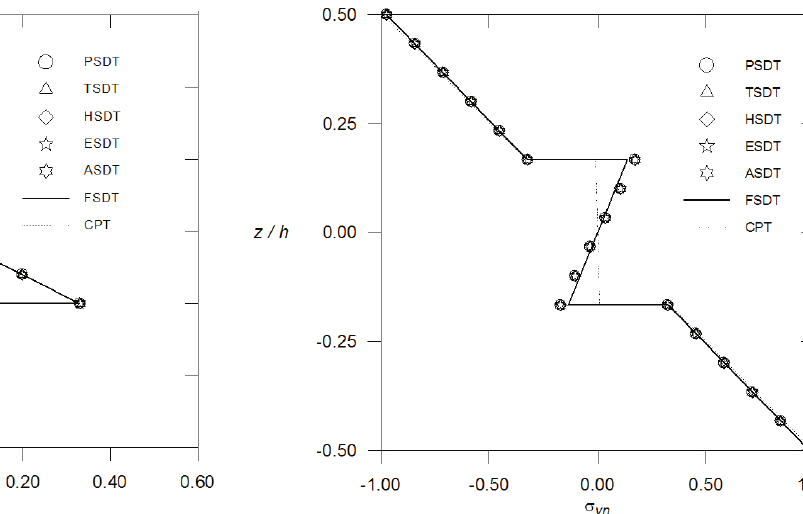
Figure 7: Variation of normalized in-plane normal stress σ y across the thickness for three layered (0 ∘ /90 ∘ /0 ∘ ) symmetric laminated composite square plate for aspect ratio 10.